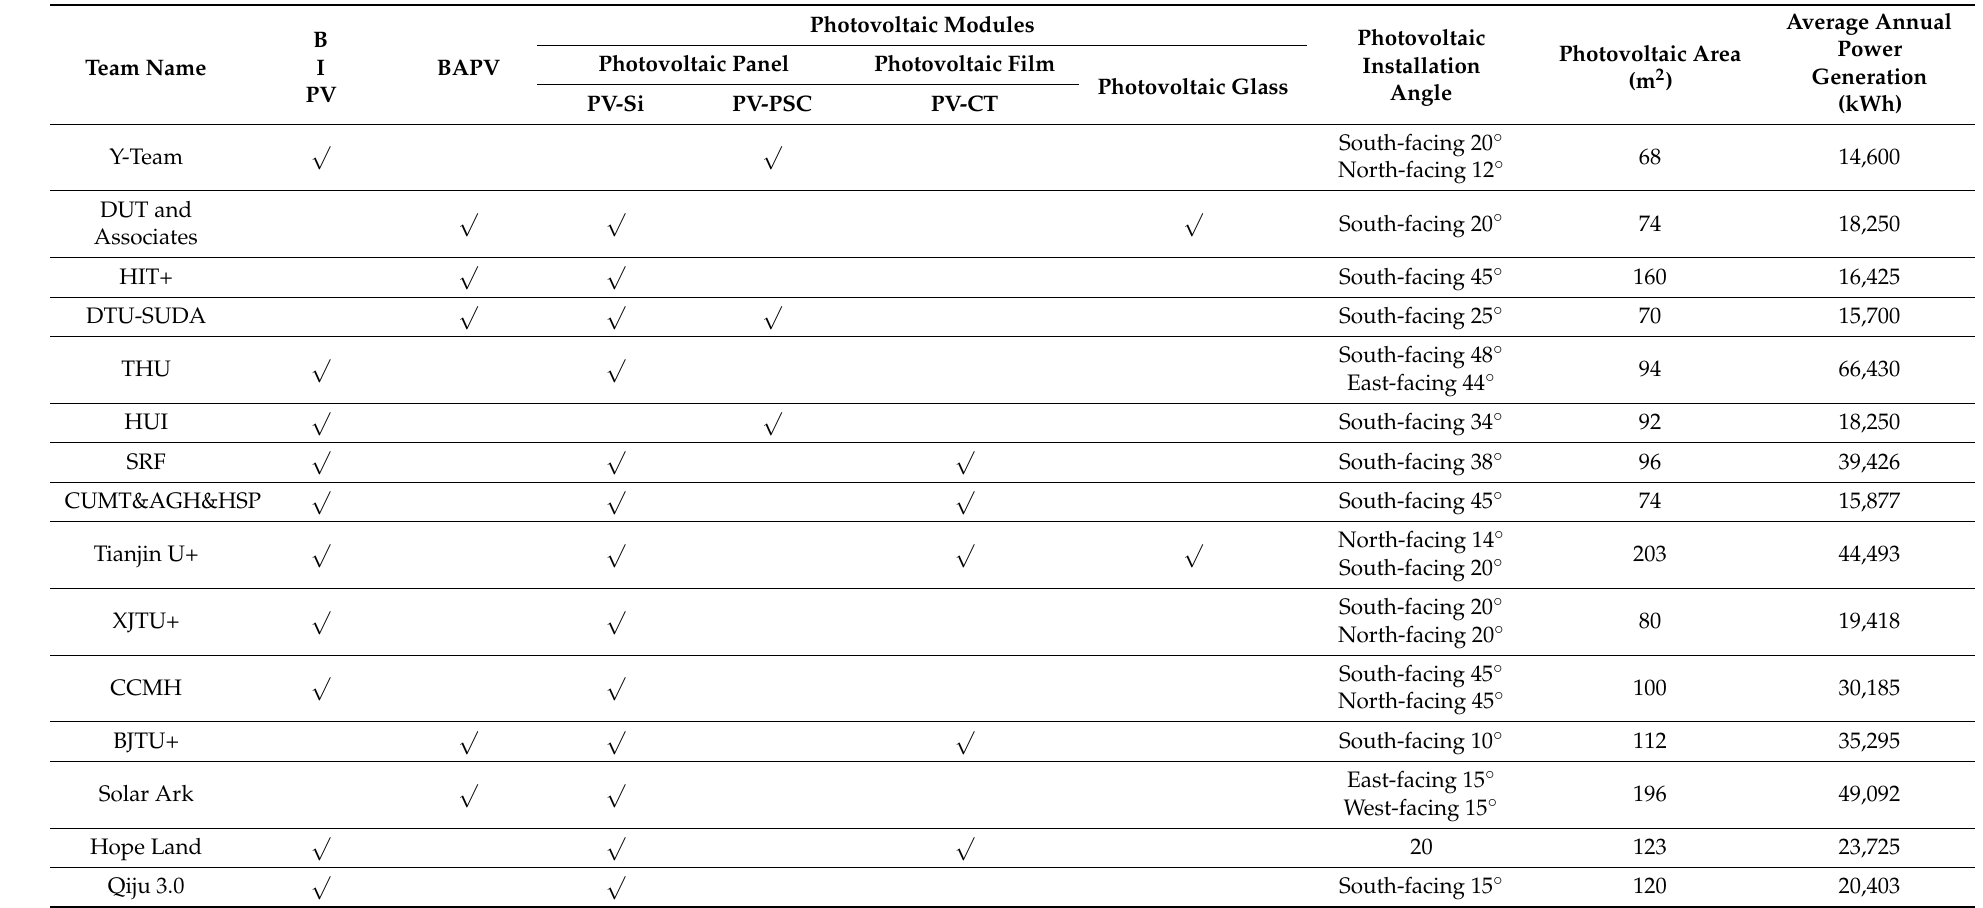
Table 7. Application of solar system